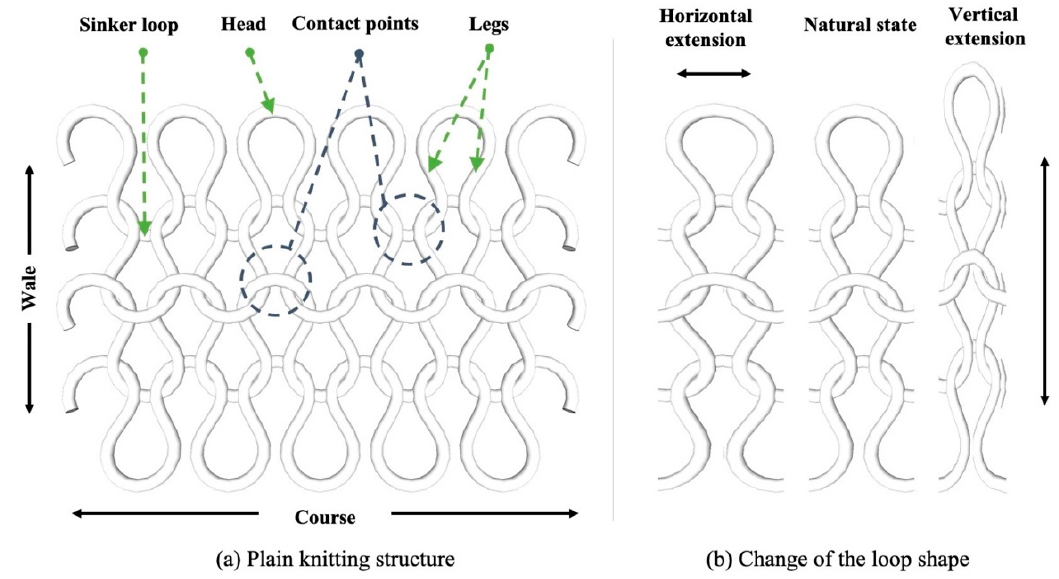
Figure 2. Schematic diagram of knitted sensing glove; ( a ) plain knitting structure; ( b ) changes of the loop shapes.